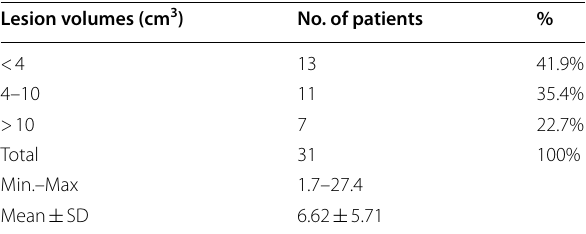
Bold values indicate the significant Z -scores (< -2) and significant P -values(< 0.05) Table 6 White matter lesions volumes distribution in the studied patients